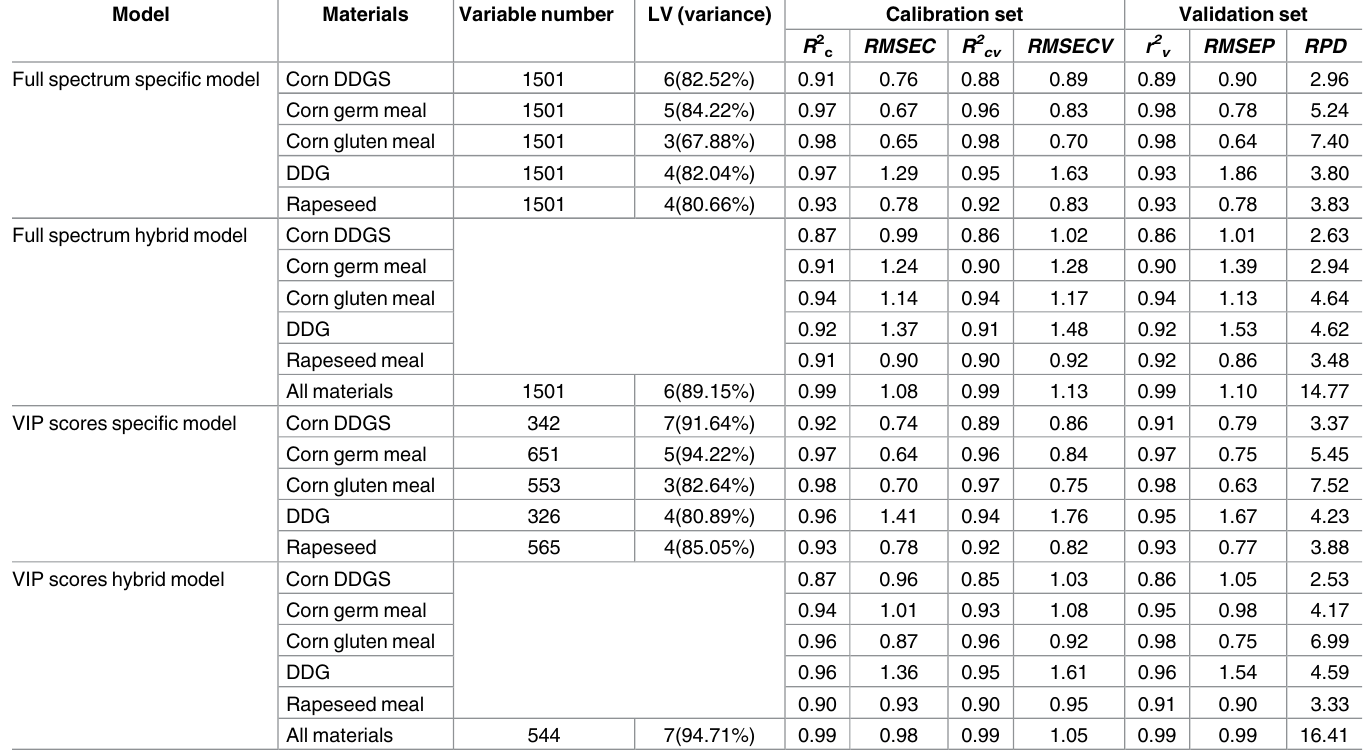
Table 2. Results of optimal NIR quantification models for different kinds of plant feed materials.